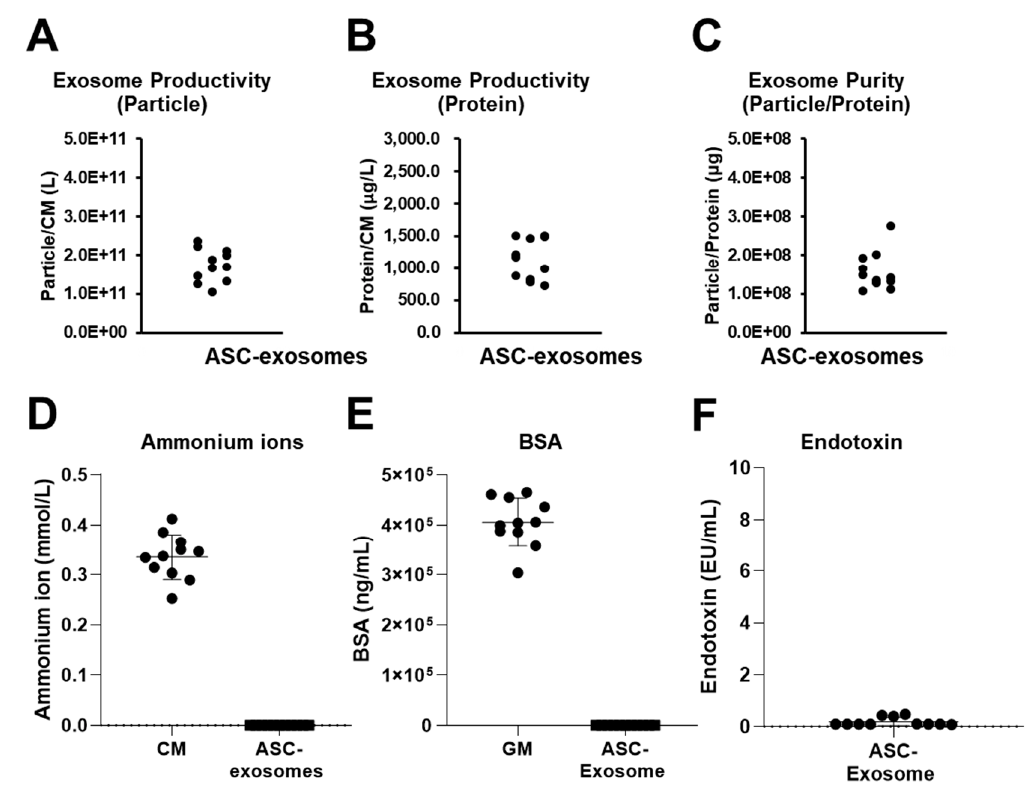
Figure 4. Reproducibility of TFF isolation of ASC-exosomes. Productivities of ASC-exosomes as ( A ) particles from 1 Liter of ASC conditioned media (ASC-CM) and ( B ) microgram of proteins from 1 Liter of ASC-CM ( n = 11). ( C ) Purities of ASC-exosomes ( n = 11). Levels of ammonium ions ( D ), bovine serum albumin (BSA) ( E ), and endotoxin ( F ) in multiple ASC-exosomes preparations ( n = 11).